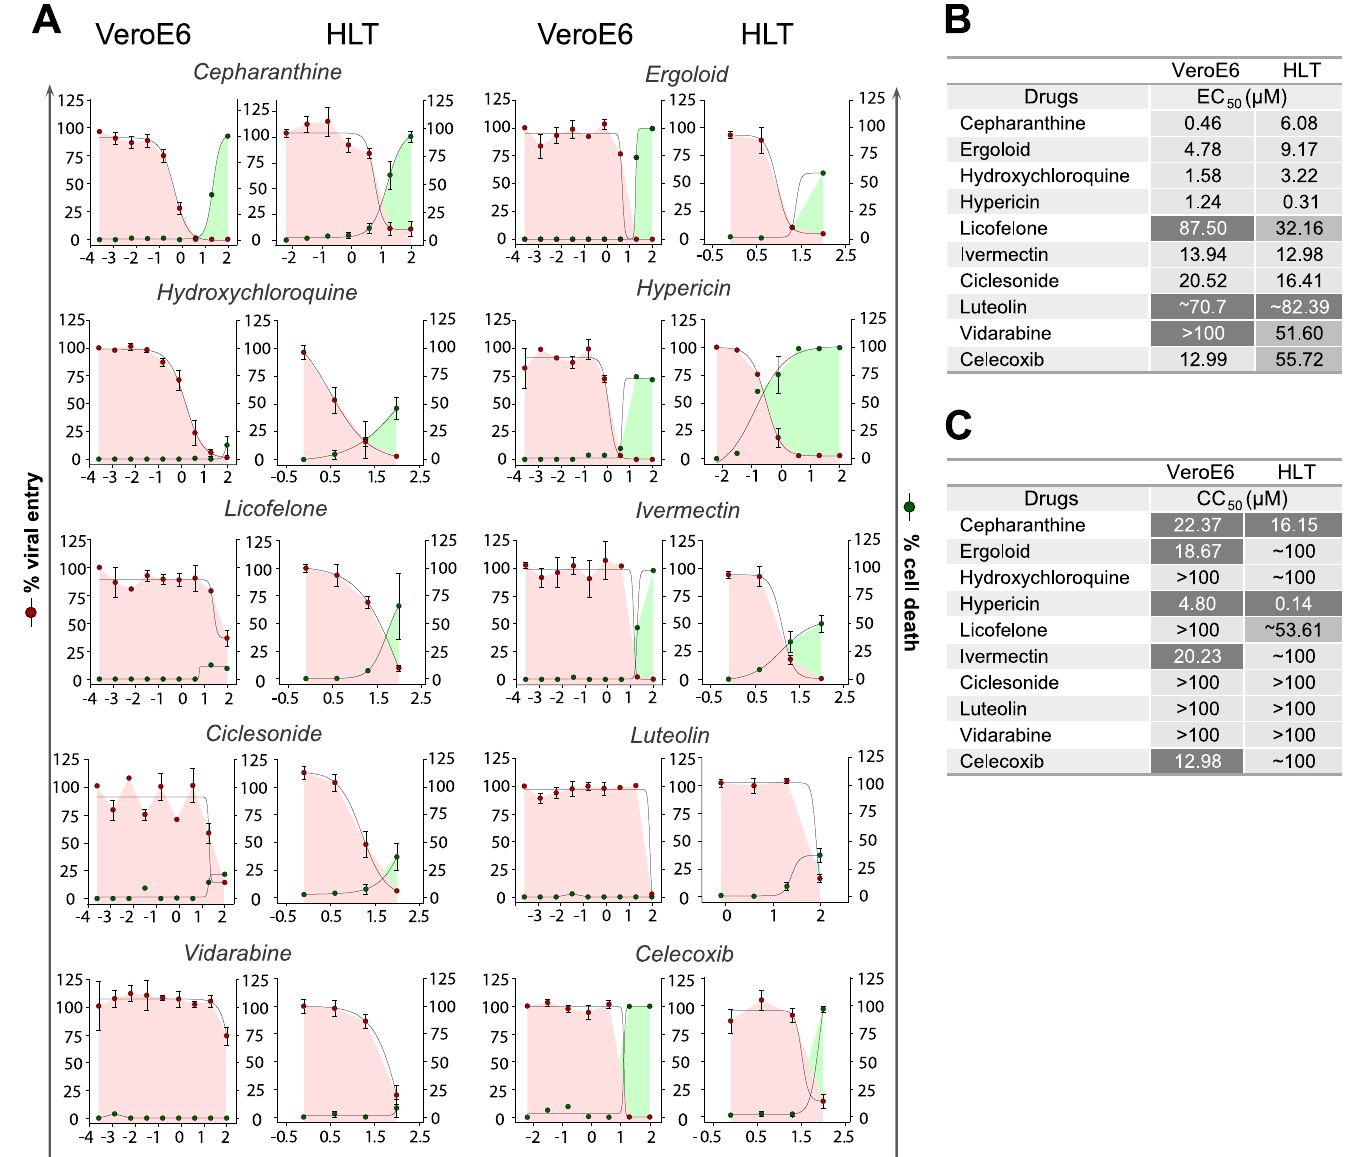
Fig 3. Antiviral assays with concordant results between models. ( A ). Percentage of viral entry in VeroE6 and HLT cells exposed to VSV � Δ G(Luc)-Spike in the presence of cepharanthine, ergoloid, hydroxychloroquine, hypericin, licofelone, ivermectin, ciclesonide, luteolin, vidarabine and celecoxib. Drugs were used at concentrations ranging from 100 μ M to 0.256nM, in VeroE6, and to 0.8 μ M in lung cells. Non-linear fit model with variable response curve from at least three independent experiments in replicates is shown (red lines). Cytotoxic effect on VeroE6 cells and HLT exposed to drug concentrations in the absence of virus is also shown (green lines). ( B ). EC 50 values of each drug in VeroE6 and HLT cells. ( C ). CC 50 values of each drug are shown for VeroE6 and for HLT